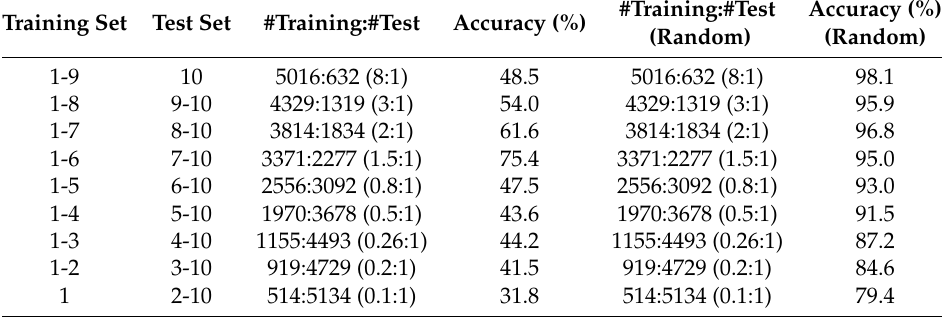
Table 7. Left : images in the training set were taken earlier than images in the test set. Right : randomly sampled training and test sets. #training:#test denotes the ratio of the number of training images to the number of test